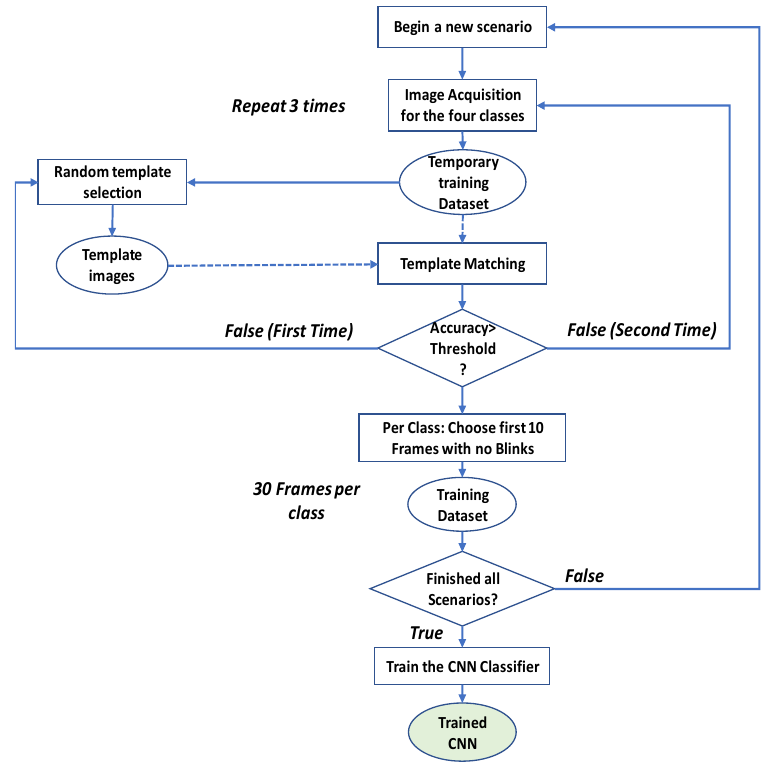
Figure 13. Flowchart for the calibration phase.